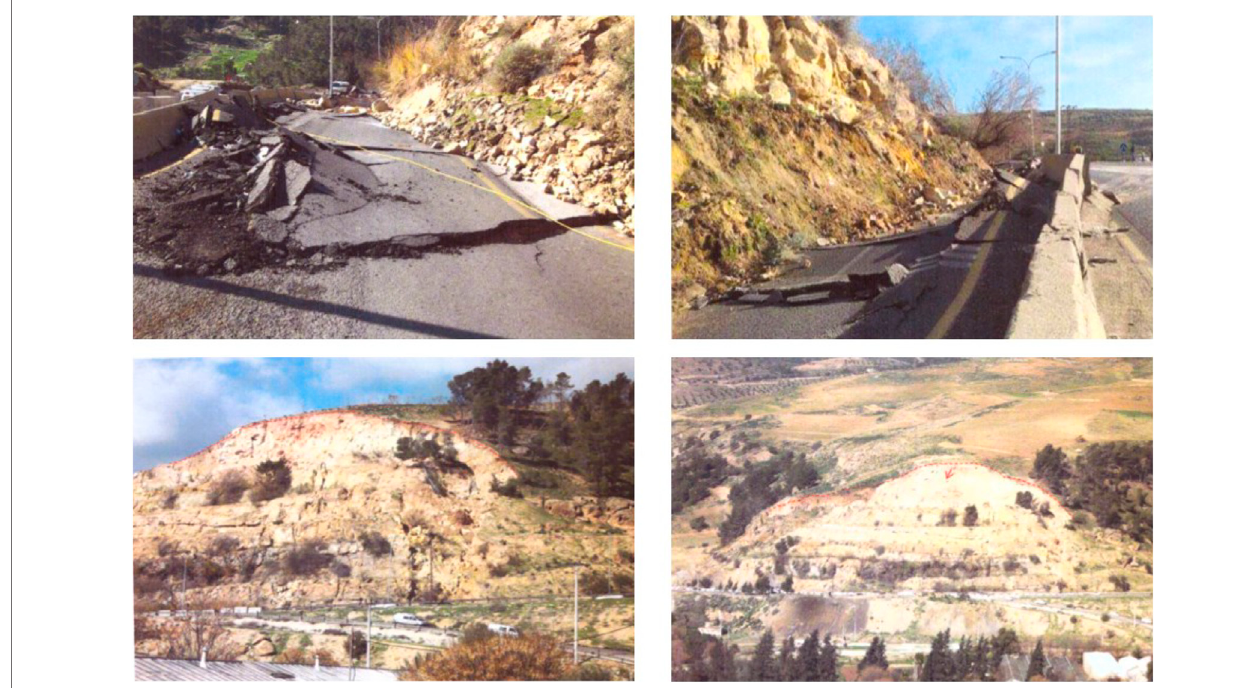
FIGURE 8 | Landslide area at Amman Jerash highway.